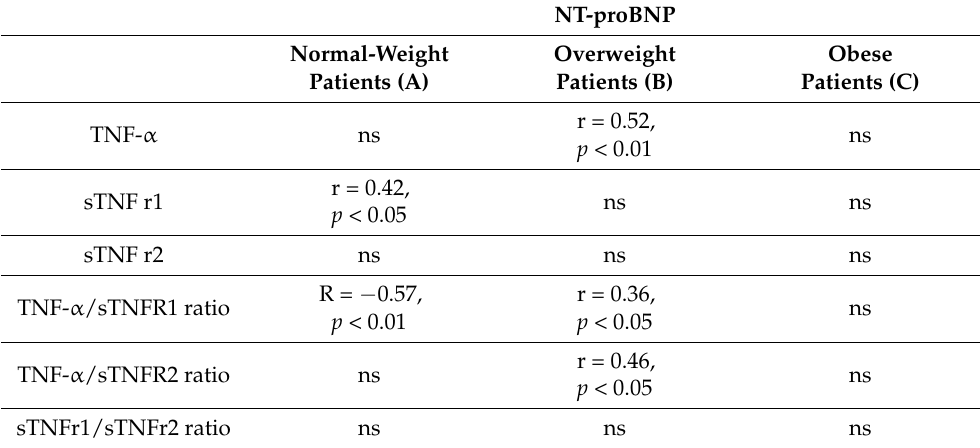
Table 6. Correlations between TNF activity and NT-proBNP in patients categorized by their